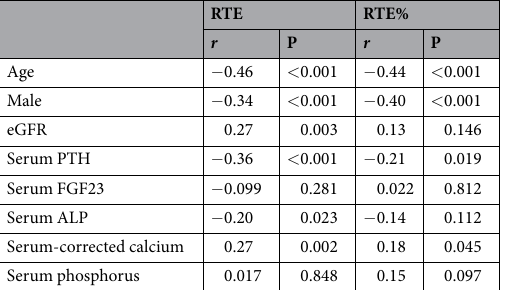
Table 2. Correlation between RTE or RTE% and characteristics of participants. RTE, recent thymic emigrants; RTE%, the proportion of recent thymic emigrants among CD4 + T cells; eGFR, estimated glomerular filtration rate; PTH, parathyroid hormone; FGF23, fibroblast growth factor 23; ALP, alkaline